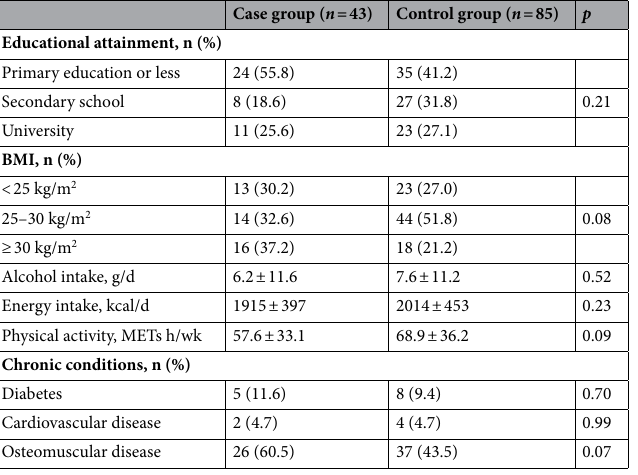
Table 1. Baseline characteristics of participants in the Seniors-ENRICA nested case–control substudy. Mean ± SD for continuous variables and n (%) for categorical variables. Unpaired t -test for continuous variables and chi-squared test for categorical variables were used for statistical